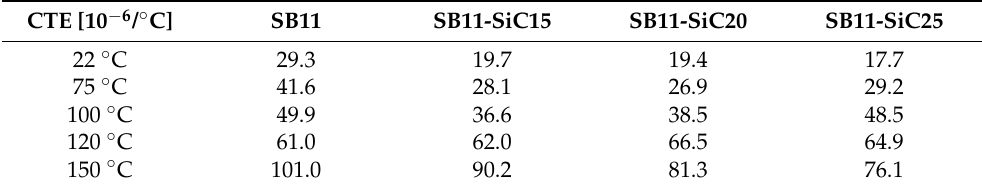
Figure 7. Maximum calculated equivalent strain of: ( a – d ) composite coating; ( e ) Ag layer and (RE)BCO layer in the samples with different filler content subjected to various quenching temperatures. Table 4. CTE of the composite systems with various SiC content at different temperatures.